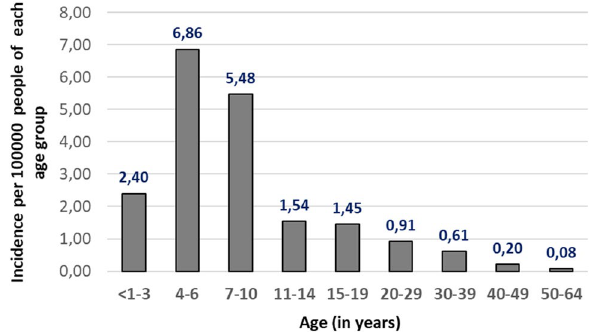
Figure 4. Erythema infectiosum incidence rates per 100,000 people of each age group, Belarus,